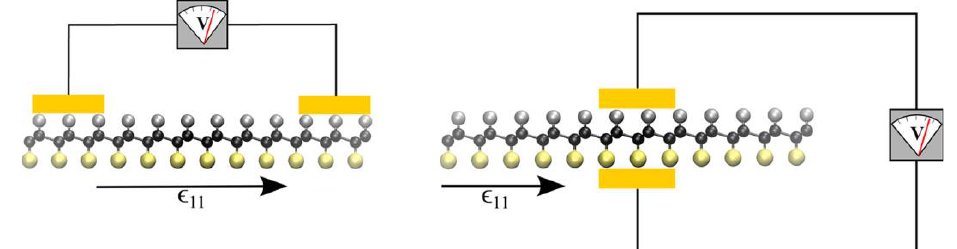
Figure 4. Hydrogen and fluorine adsorbed on the different side of graphene induced both in-plane and out-of-plane piezoelectric effects [107]. Reprinted with permission from [107]. Copyright 2013 American Chemical Society.